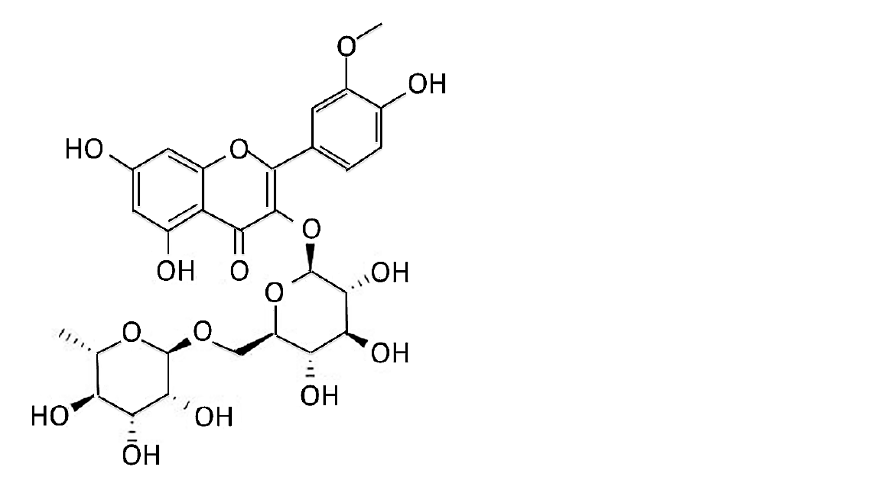
Figure 1. Chemical structure of narcissoside (NCS) from Sambucus nigra flowers (elderflowers). In this study, we used SH-SY5Y cells as an in vitro model and Caenorhabditis elegans ( C. elegans ) as an in vivo model to evaluate the neuroprotective properties of NCS in 6-OHDA causing cytotoxicity and to indicate NCS acting mechanisms. C. elegans is a facile animal